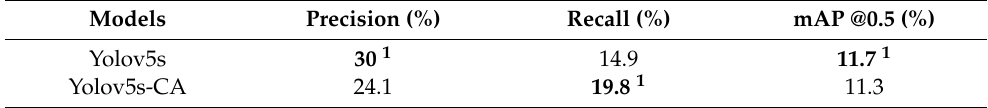
Table 2. Performance comparisons of the model trained only on the synthetic dataset.